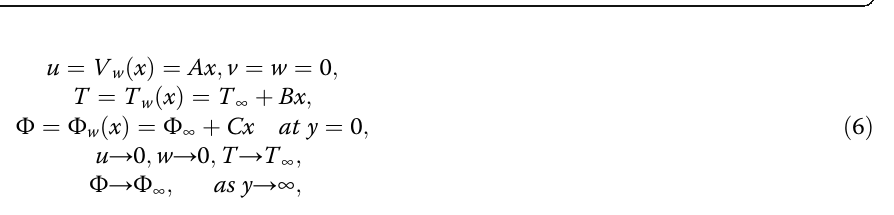
Fig. 3 Graph of cross flow velocity for various values of M